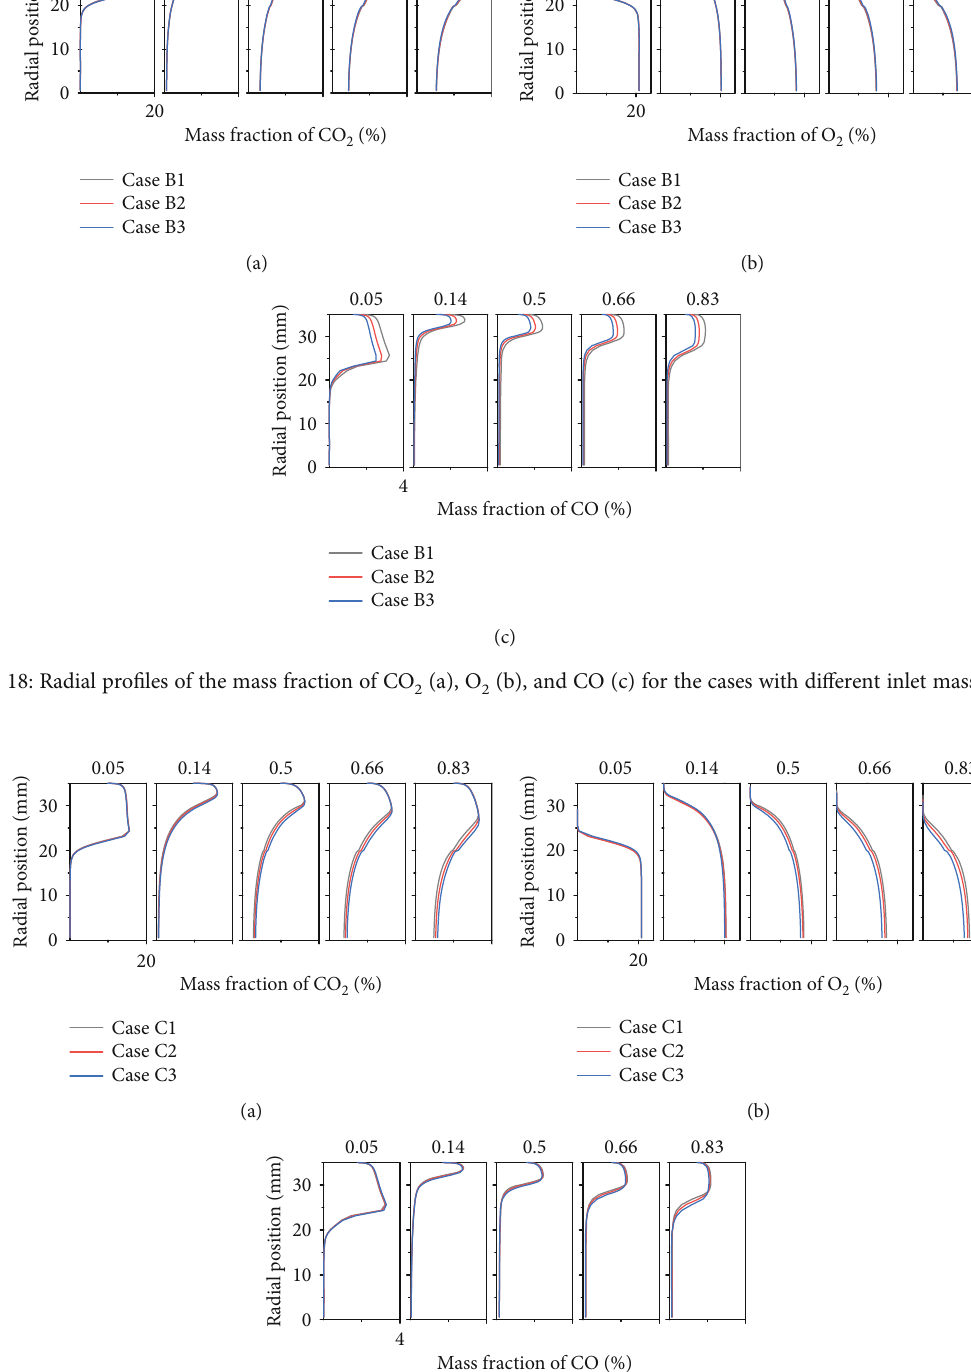
(a), O (b), and CO (c) for the cases with di ff erent inlet 2 2